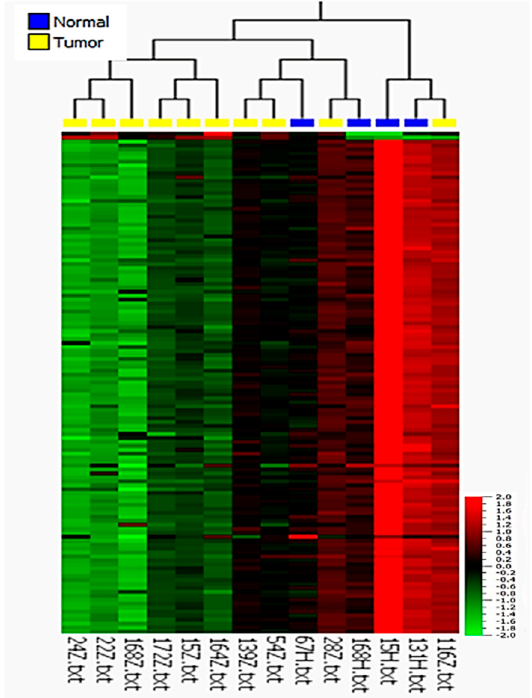
Figure 5. Heat map after unsupervised hierarchical clustering of differentially expressed miRNAs in basaloid, warty, and warty–basaloid (HPV-positive) PSCC versus related normal tissue samples ( p ≤ 0.05; q ≤ 0.17; fold change ≥ 2).